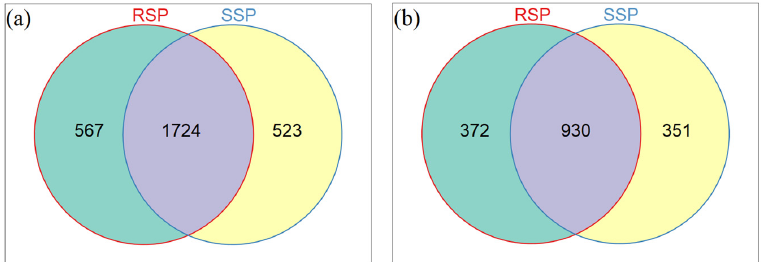
Figure 2. Venn diagrams showing the number of shared and unique OTUs between groups. ( a ) Bacteria and ( b ) fungi. Each circle represents sampled compartments. Values within intersections represent shared OTUs, values outside intersections represent unique OTUs.